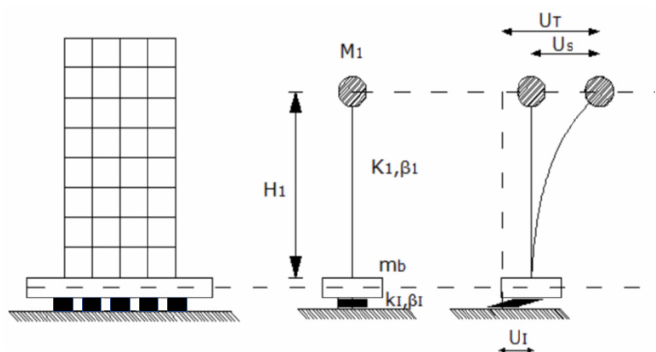
Figure 21. Equivalent 2DOF system for seismically isolated structure for DDBD.